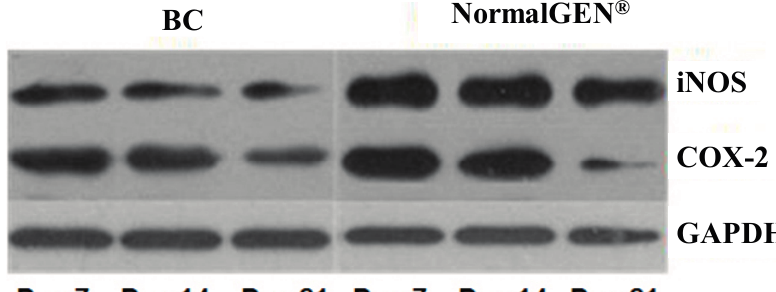
Figure 5. West Blot (WB) contrast effect of bacterial cellulose (BC) and NormalGEN ® on iNOS and